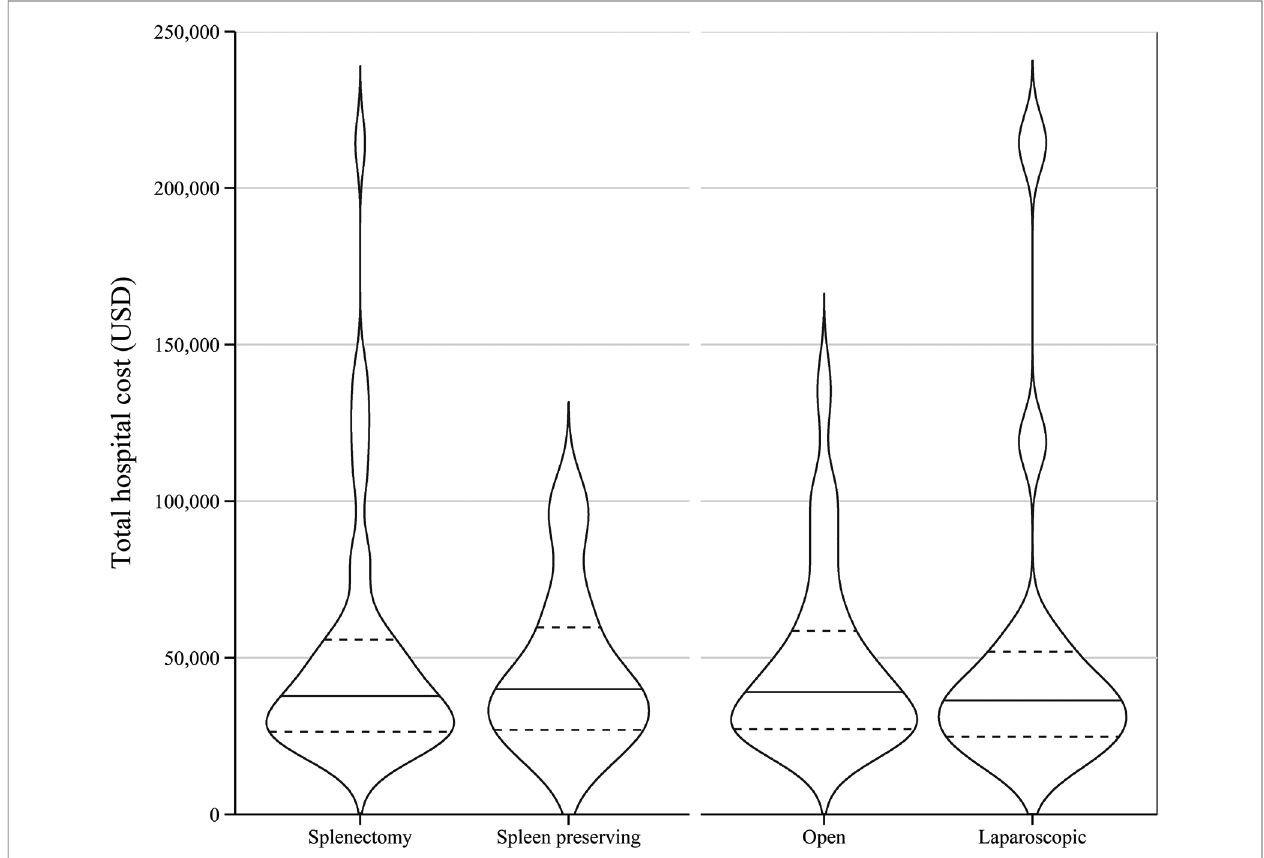
FIGURE 3 | Unadjusted hospital cost of distal pancreatectomy with or without splenectomy and between open and laparoscopic